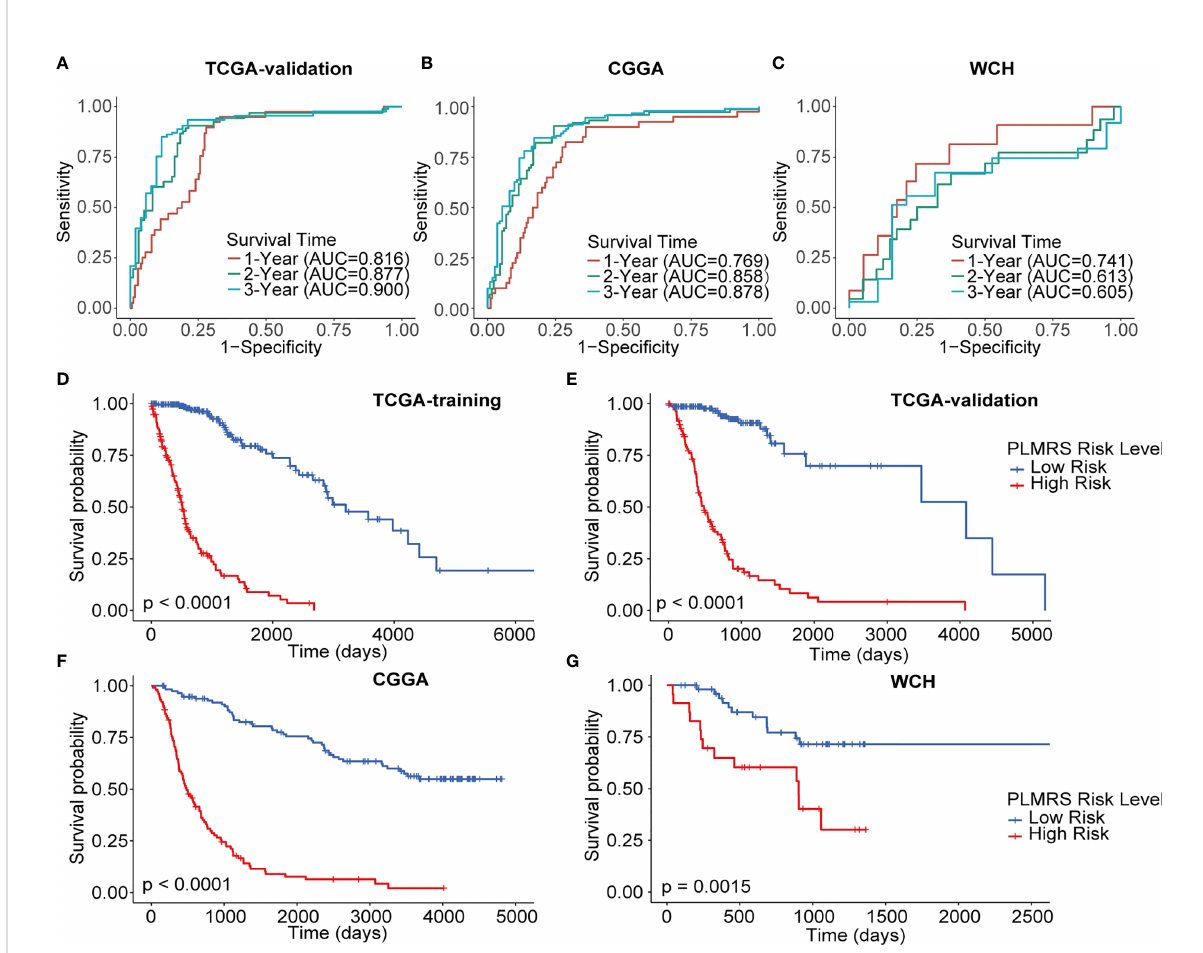
FIGURE 7 Prognostic value of PLMRS. ROC curves and matched AUC of 1-, 2-, 3-year survival in TCGA validation group (A) , CGGA (B) and WCH (C) . K-M curves of high-risk and low-risk groups in TCGA training group (D) , TCGA validation group (E) , CGGA (F) and WCH (G) . TCGA, The Cancer Genome Atlas; CGGA, Chinese Glioma Genome Atlas; WCH, West China Hospital; PLMRS, prognostic lactate metabolism risk score; ROC, receiver operating characteristic curve; AUC, area under the